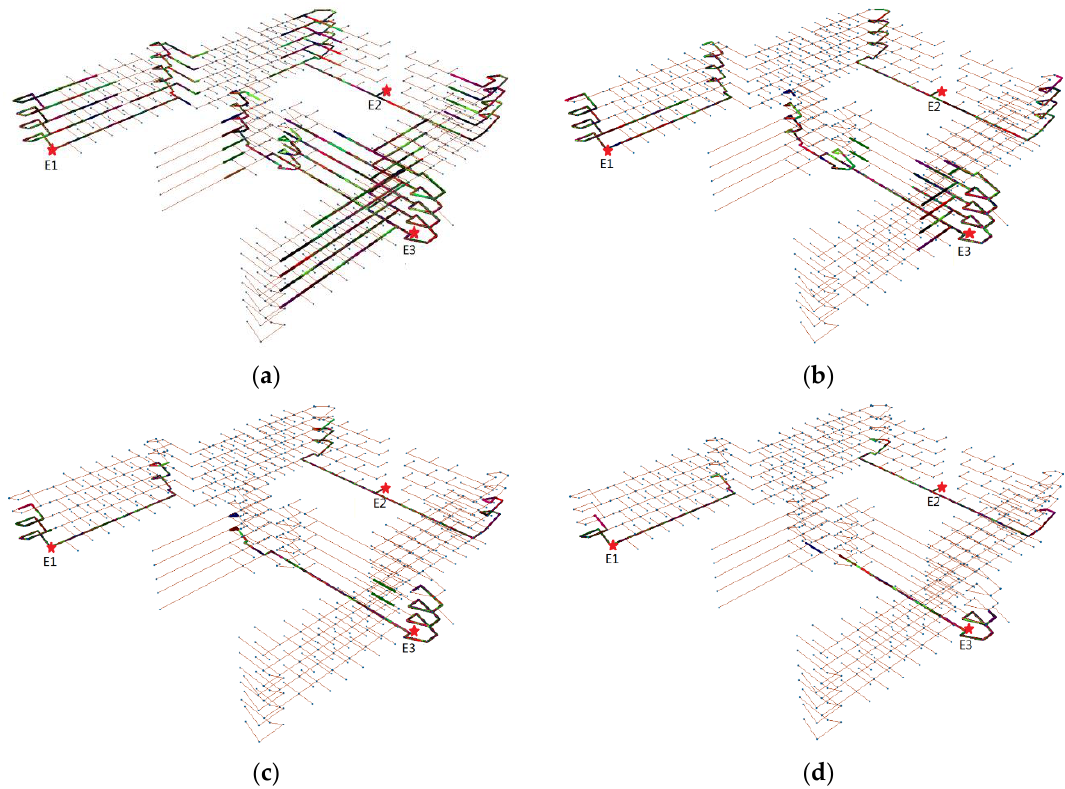
Figure 14. The simulation of simultaneous evacuation for the multi-exit network. Four screenshots are given at different times as follows: ( a ) t0 + 8 s; ( b ) t0 + 16 s; ( c ) t0 + 24 s; ( d ) t0 + 32 s.